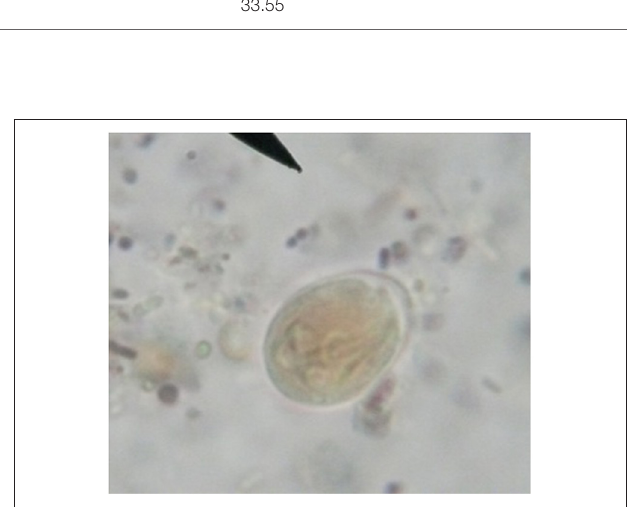
FIGURE 2 | Fresh fecal smear showing Giardia bovis cyst (X40, Bar = 10 µ m).